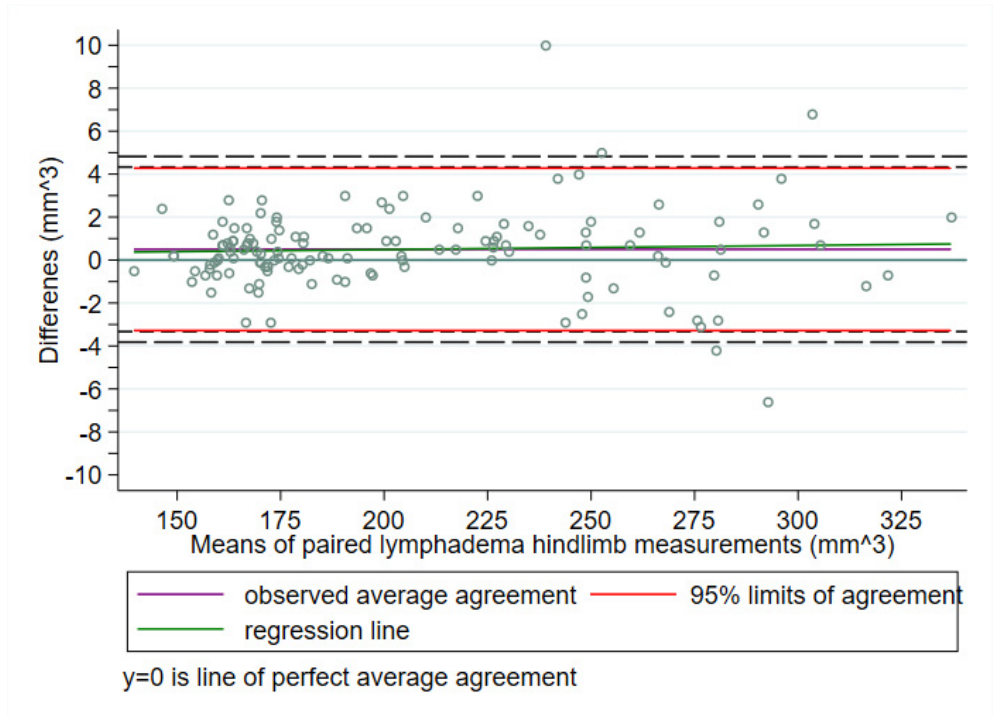
Figure 2. Classical Bland–Altman plot including the estimated LoA and a regression line of the differences on the means, extended by a prediction interval for a future difference (short dashes) and exact outer 95% confidence limits for the LoA (long dashes).